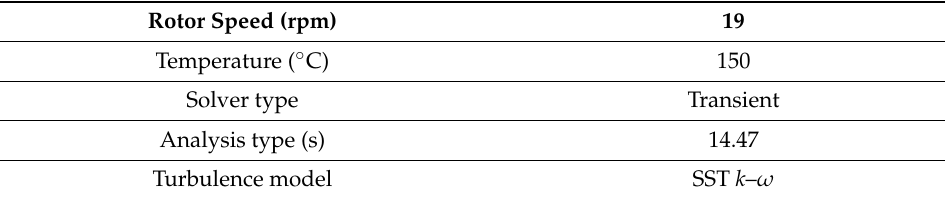
Figure 8. Boundary condition. Table 1. Analysis conditions.